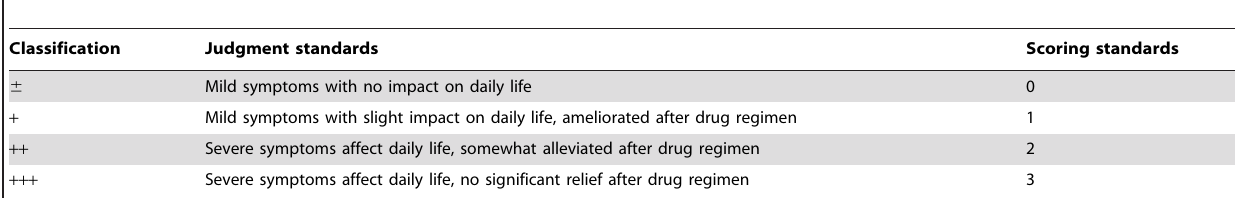
Table 1. Classification and scoring criteria of the symptoms of high-altitude de-acclimatization syndrome.